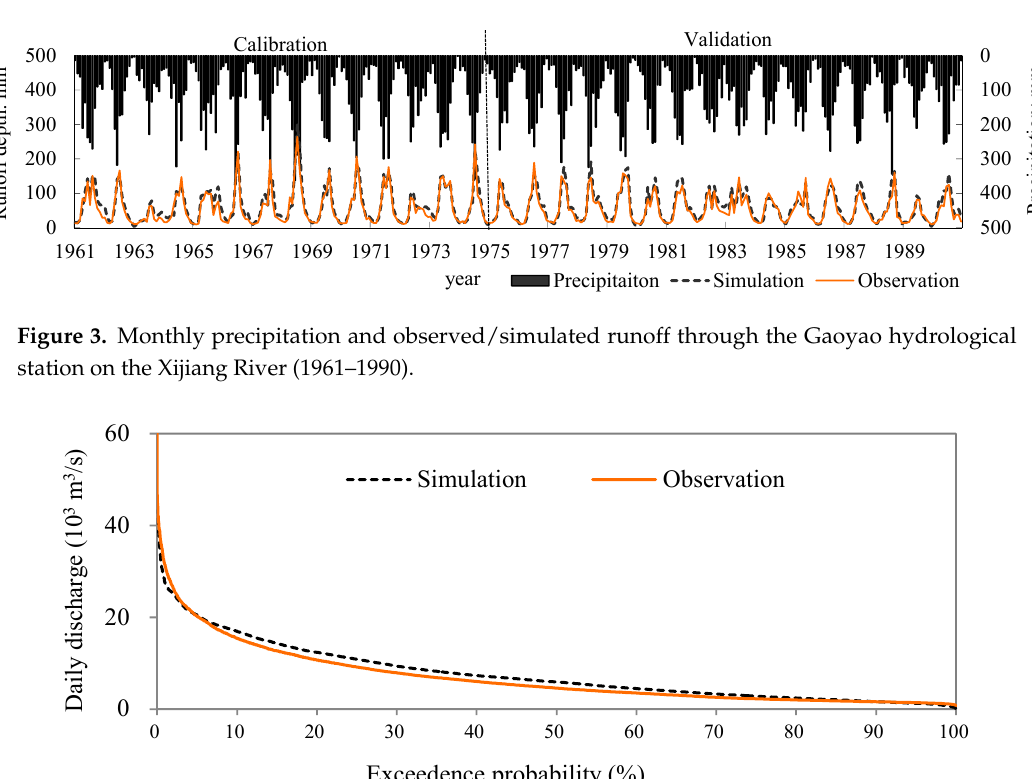
Figure 3. Monthly precipitation and observed/simulated runoff through the Gaoyao hydrological station on the Xijiang River (1961–1990).